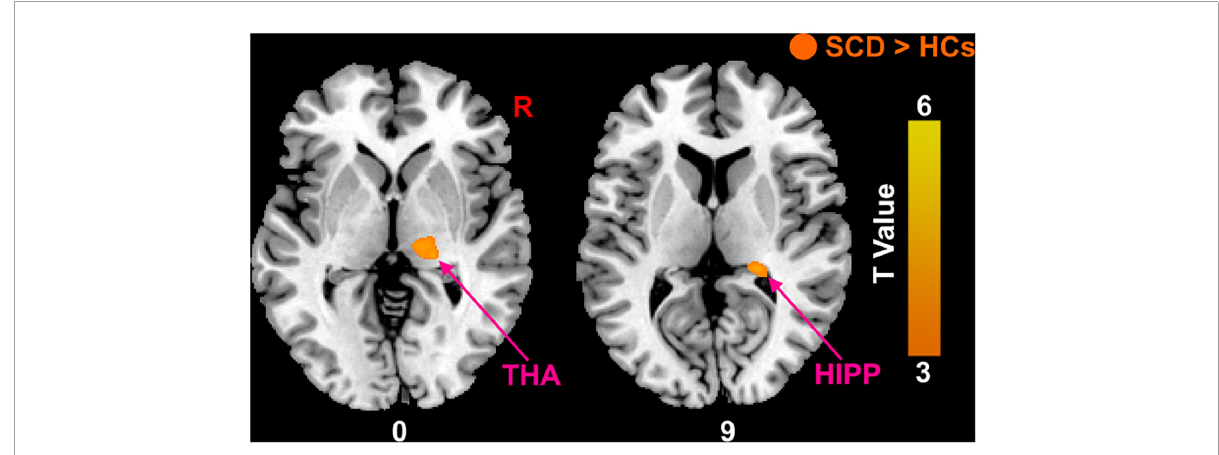
FIGURE1 The PerAF differences between subjective cognitive decline (SCD) patients and healthy controls (HCs). Brain regions marked by warm color represent significantly increased PerAF in patiens with SCDs relative to